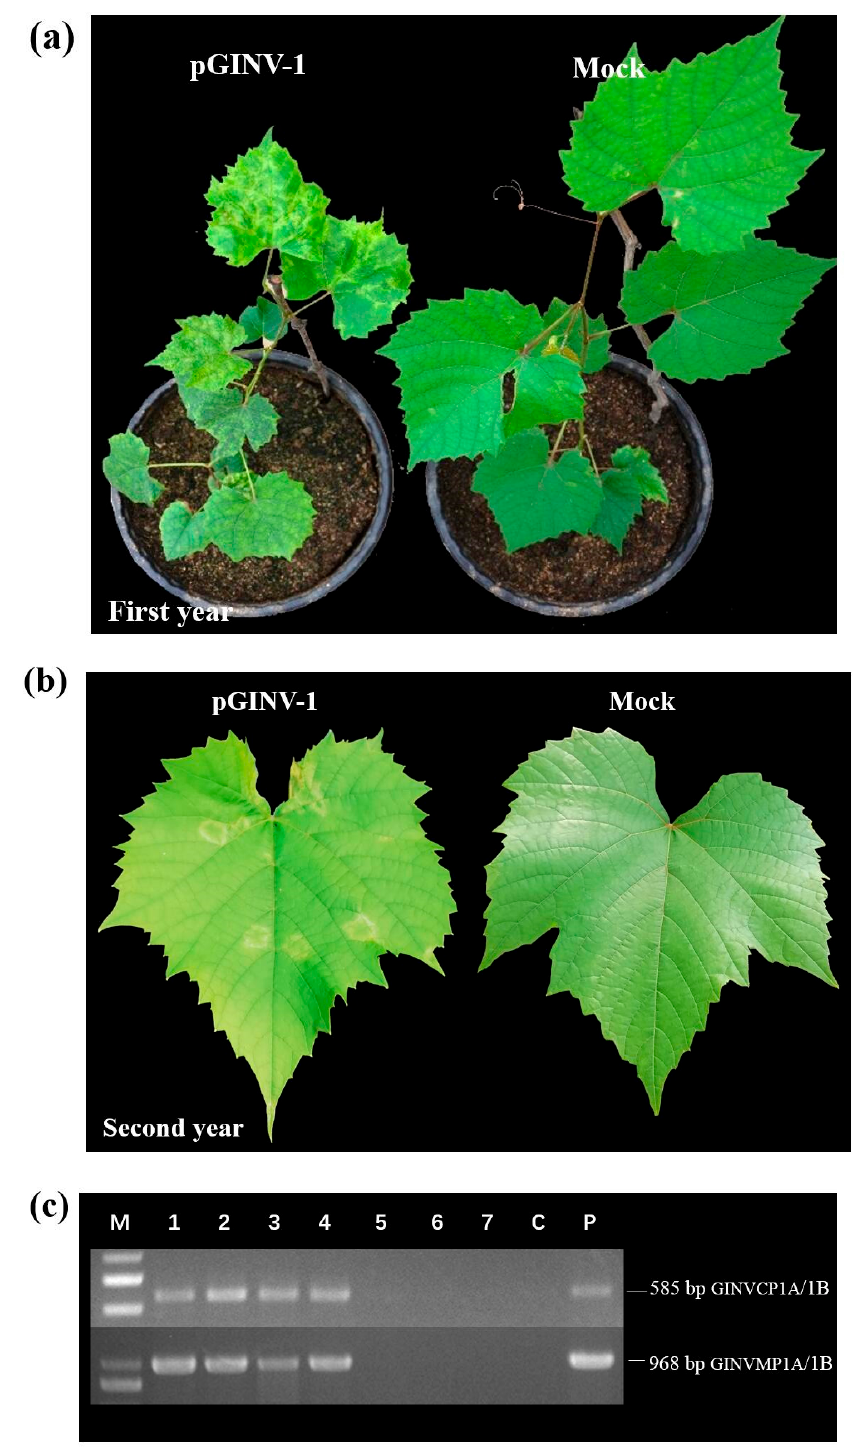
Figure 3. Infectivity test of pGINV-1 in “Beta” grapevines. ( a ) Agroinoculated “Beta” and control grapevines three months after agroinoculation. Mock, infiltrated with agrobacterial cells containing the empty pXT1 vector; ( b ) Agroinoculated “Beta” and control grapevines two years after agroinoculation; ( c ) RT-PCR detection of GINV in inoculated “Beta” grapevines using two GINV primer pairs. M, DL2000 (TaKaRa, Dalian, China), P, positive control and C, negative control;